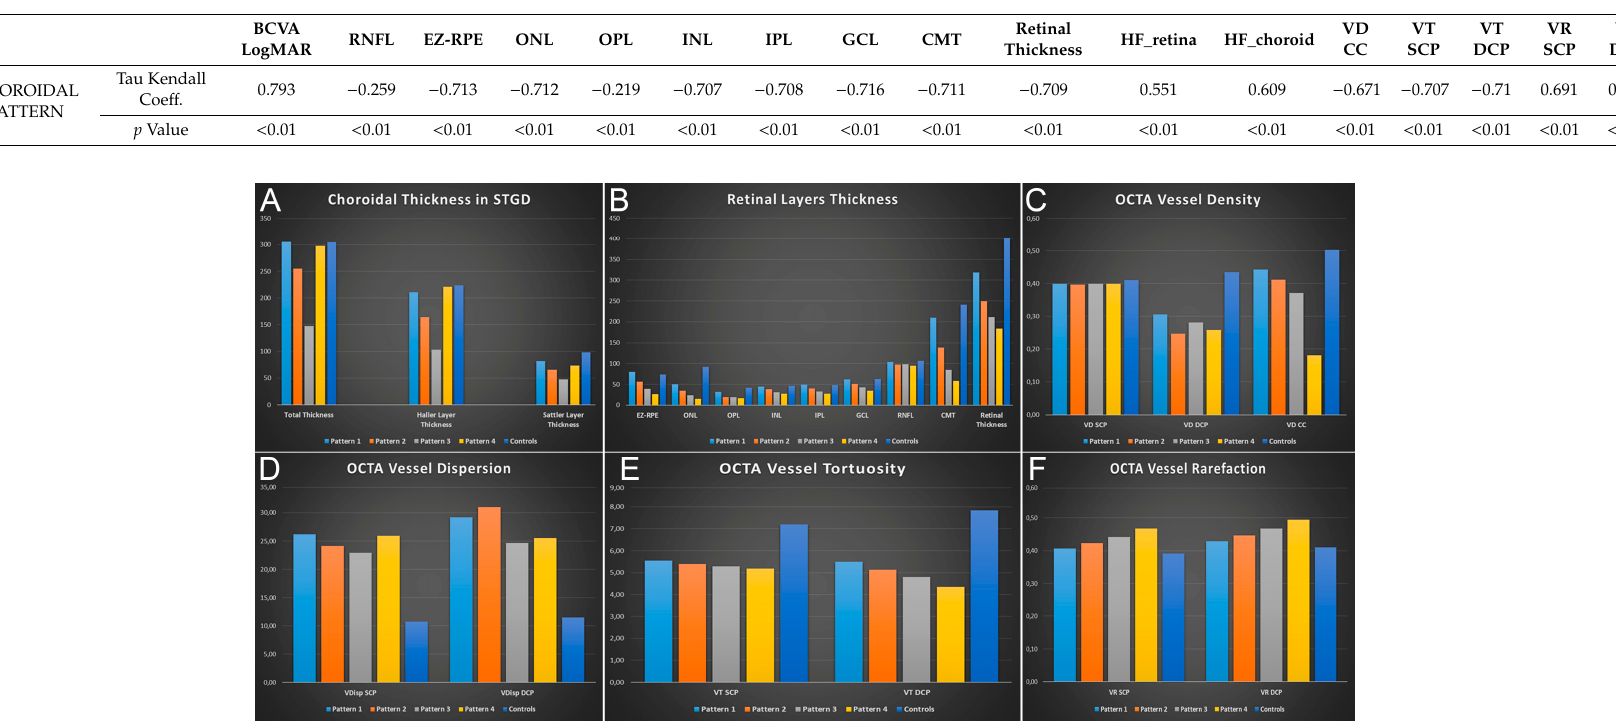
Table 2. Correlation Analysis.